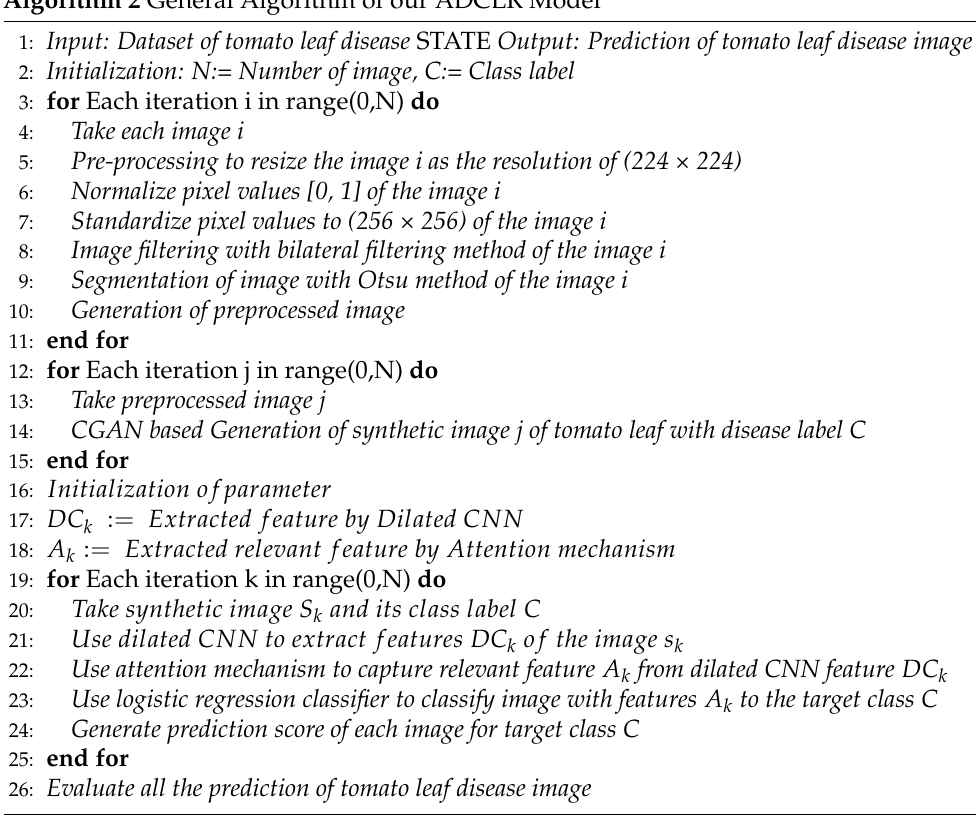
Figure 5. The overall procedure of the DCLR model. Algorithm 2 General Algorithm of our ADCLR